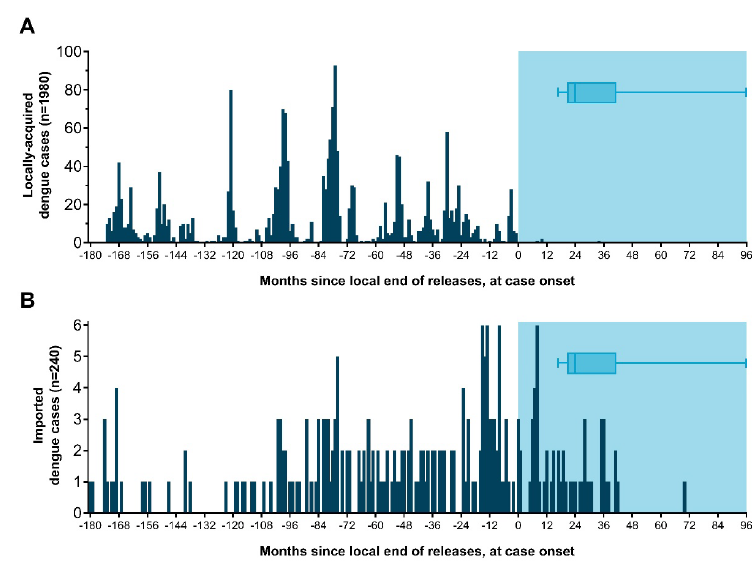
Figure 17. Timing of dengue case notifications January 2000 – March 2019 from Wolbachia intervention areas, relative to Wolbachia deployments. The date of case onset is scaled relative to the date that local Wolbachia releases were completed or, for the five central Cairns non-release areas where Wolbachia established, the inferred date when local Wolbachia frequency reached 80%. In the post-intervention period (blue shaded area), imported cases continue to occur ( B ) but locally-acquired cases have been effectively eliminated ( A ). The post- intervention case surveillance period is variable across the release areas, due to staggered releases from Jan 2011 to May 2017: the median post-intervention observation period is 24 months (IQR 21–41 months, range 17–96 months), as shown in the box plots. The x-axis is left- censored at 15 years pre-release (excludes 8 local cases and 5 imported cases occurring >15 years pre-release).